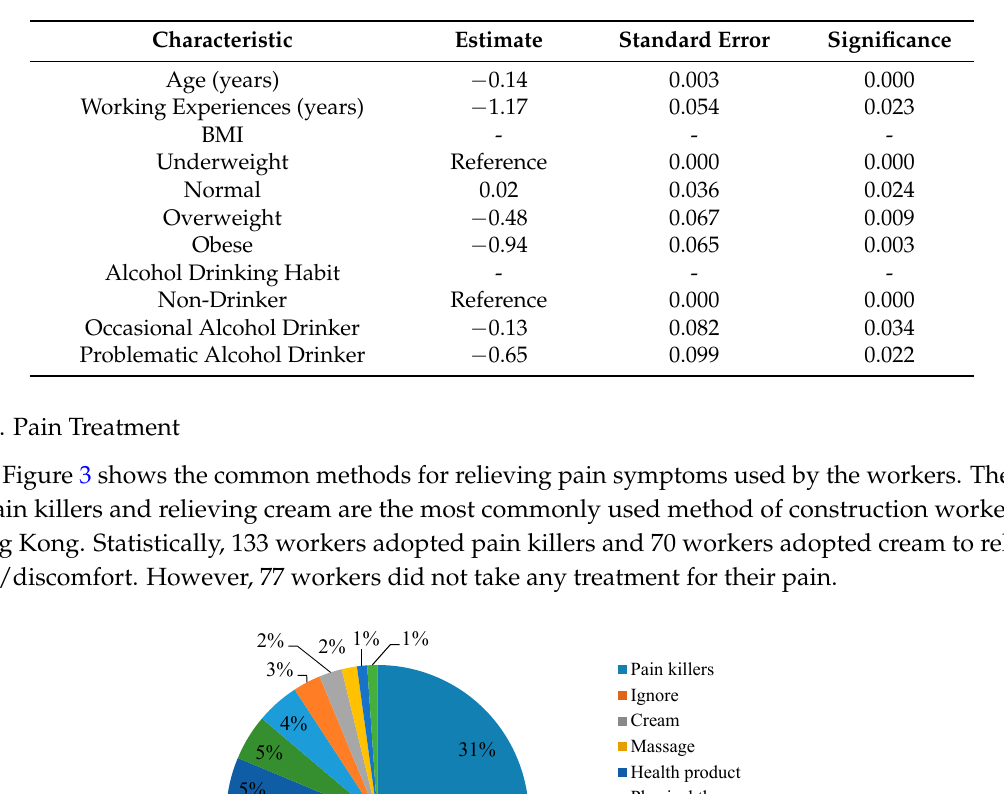
Table 5. Multivariate analysis of the relationship between musculoskeletal pain and age, BMI, alcohol drinking habits, working experience among construction workers in Hong Kong.